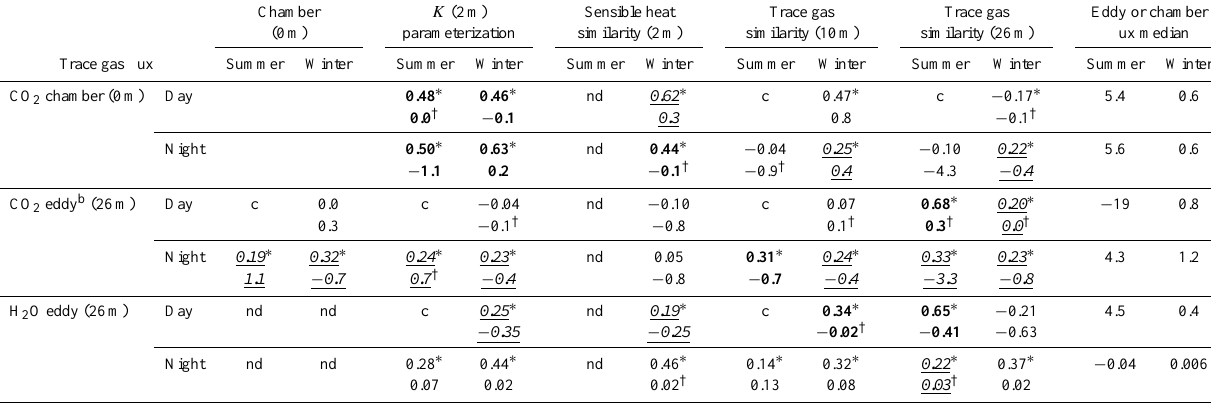
Table 2. Quantitative comparison of CO 2 and H 2 O fluxes determined by flux-gradient methods and by independent eddy covariance and chamber measurements. Trace gas similarity fluxes were corrected in this table (Sect. 4.2). First, the correlation between flux method pairs ( r , Pearson’s linear correlation coefficient) is given, and statistically significant correlations are indicated by ∗ (Student’s t test, p value<0.05, α = 0 . 05). Second, the median of the bias over the period (column header minus row) is given in µmolCO 2 m − 2 s − 1 and mmolH 2 Om − 2 s − 1 , and instances when this mean bias is not significantly different from zero are indicated by † (Student’s t test, p value>0.05, α = 0 . 05). A text-type flag a is assigned to each flux-gradient method to indicate the level of performance against the inde- pendent flux methods: good (bold), fair (underlined italic), and poor (plain text). Data are grouped into summer (23 June 2011 to 16 Octo- ber 2011) and winter (15 November 2011 to 28 February 2012) and daytime (10:00–16:00LT) and nighttime (21:00–05:00LT) periods. The comparison is not made for the chamber–chamber comparison, for periods with no data (nd), and across the canopy when in-canopy fluxes are significant (c).